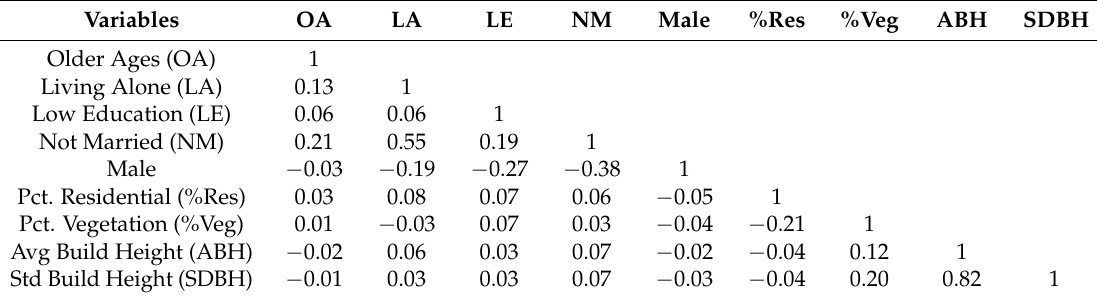
Table 2. Correlation matrix of the analytic